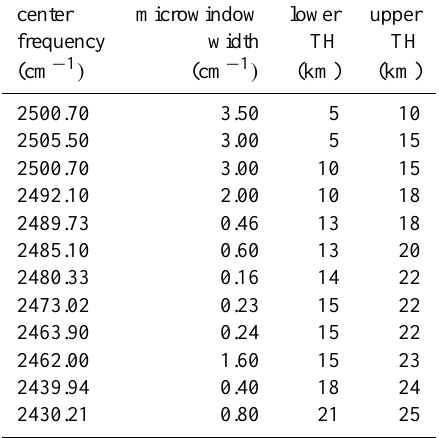
Table 2. CO 2 microwindows: Center frequencies, widths, and tan- gent height ranges in order of increasing center